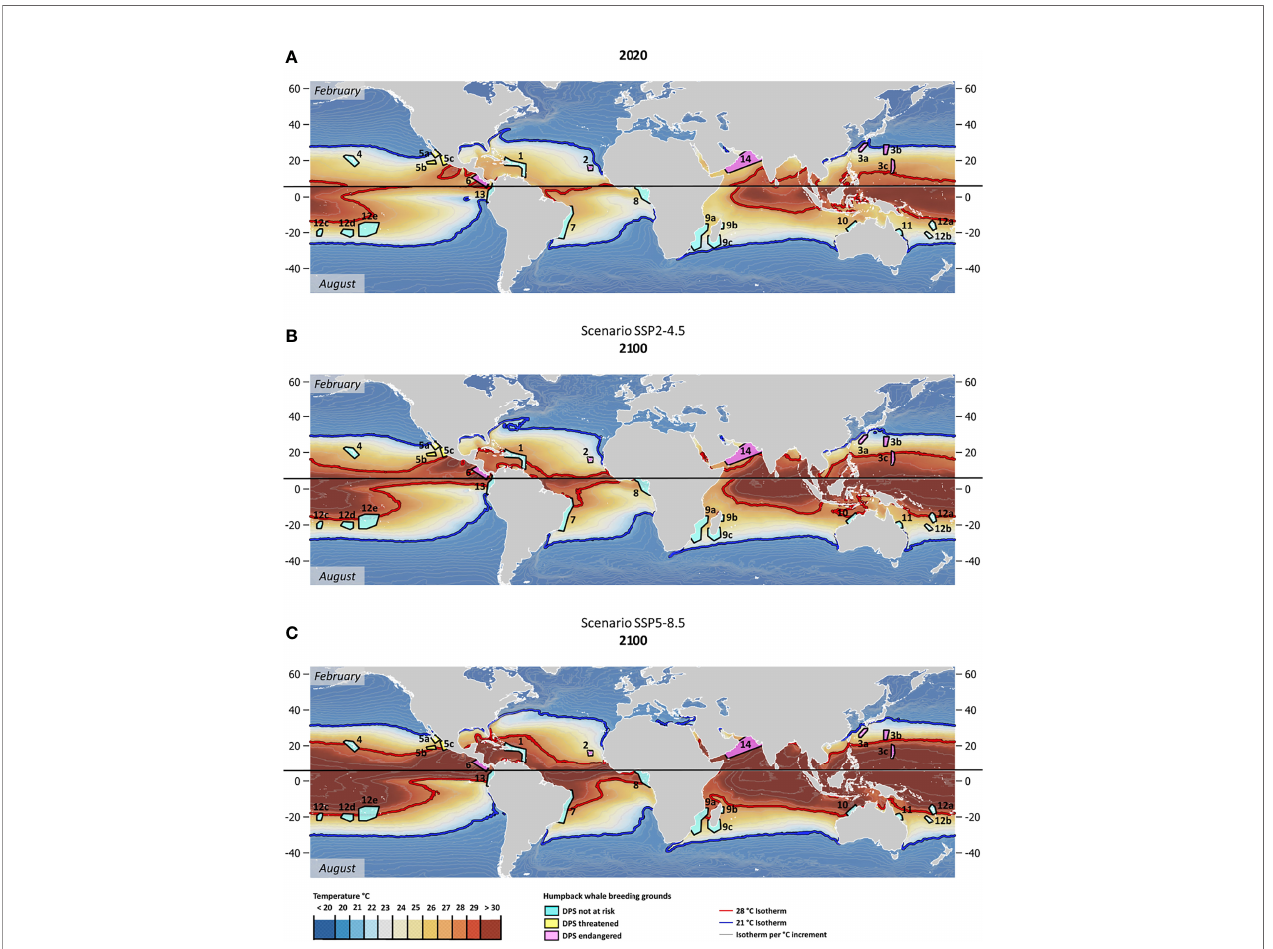
FIGURE 2 | (A) Year 2020 mean monthly SST (in °C) for February (Northern Hemisphere) and August (Southern Hemisphere); (B) Year 2100 mean monthly SST projections for February (Northern Hemisphere) and August (Southern Hemisphere) under the SSP2-RCP4.5 greenhouse gas concentration scenario and (C) Year 2100 mean monthly SST projections for February (Northern Hemisphere) and August (Southern Hemisphere) under the SSP5-RCP8.5 greenhouse gas concentration scenario. Polygons correspond to humpback whale breeding areas colored according to the Distinct Population Segments ’ (DPS) conservation status. Grey lines are corresponding to 1°C isotherms. The 21°C isotherm is highlighted in blue and the 28°C isotherm in red. Northern and Southern Hemispheres (February and August means) separated by a black bar. Numerical population codes correspond to DPS as listed in Tables 1 and 2